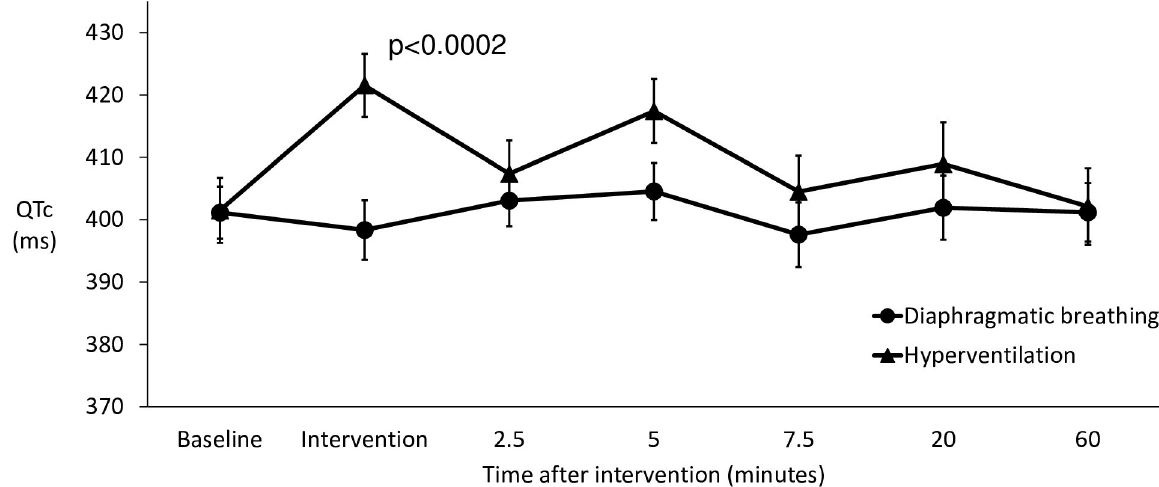
Fig 4. The effects of hyperventilation versus diaphragmatic breathing on the QTc of all participants in the first 60 minutes.